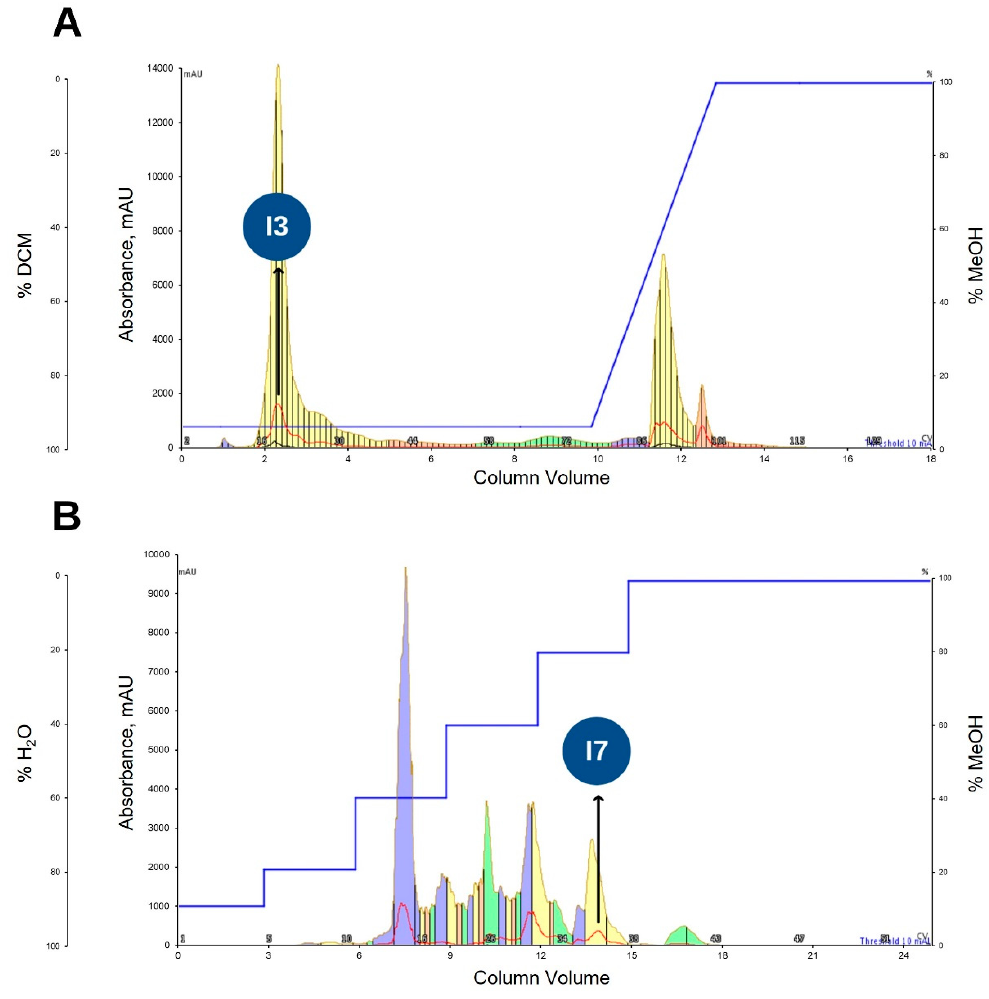
Figure 3. Bioassay-guided fractionation using flash column chromatography. ( A ) Chromatogram from the purification of KADAME fraction using normal phase chromatography. Peak annotated with black arrow as I3 in blue circle corresponds to the early eluting fraction KADAMEI3, which exhibited bioactivity against MDRSA. ( B ) Chromatogram from the subsequent purification of fraction KADAMEI3 using reversed phase flash column chromatography. Peak annotated with black arrow as I7 in blue circle corresponds to fraction KADAMEI3I7, which exhibited activity against MDRSA. UV λ max 254 nm (red curve) and λ max 365 nm (black